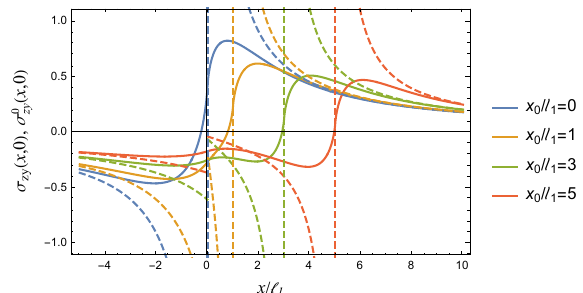
Figure 3: The profile of σ zy ( x , y = 0) when µ 2 / µ 1 = 10 , l 2 / l 1 = 2 , and the dislocation is placed at different locations x dashed curves are pertinent to the gradient and classical solutions, respectively. The stress values are given in units of µ